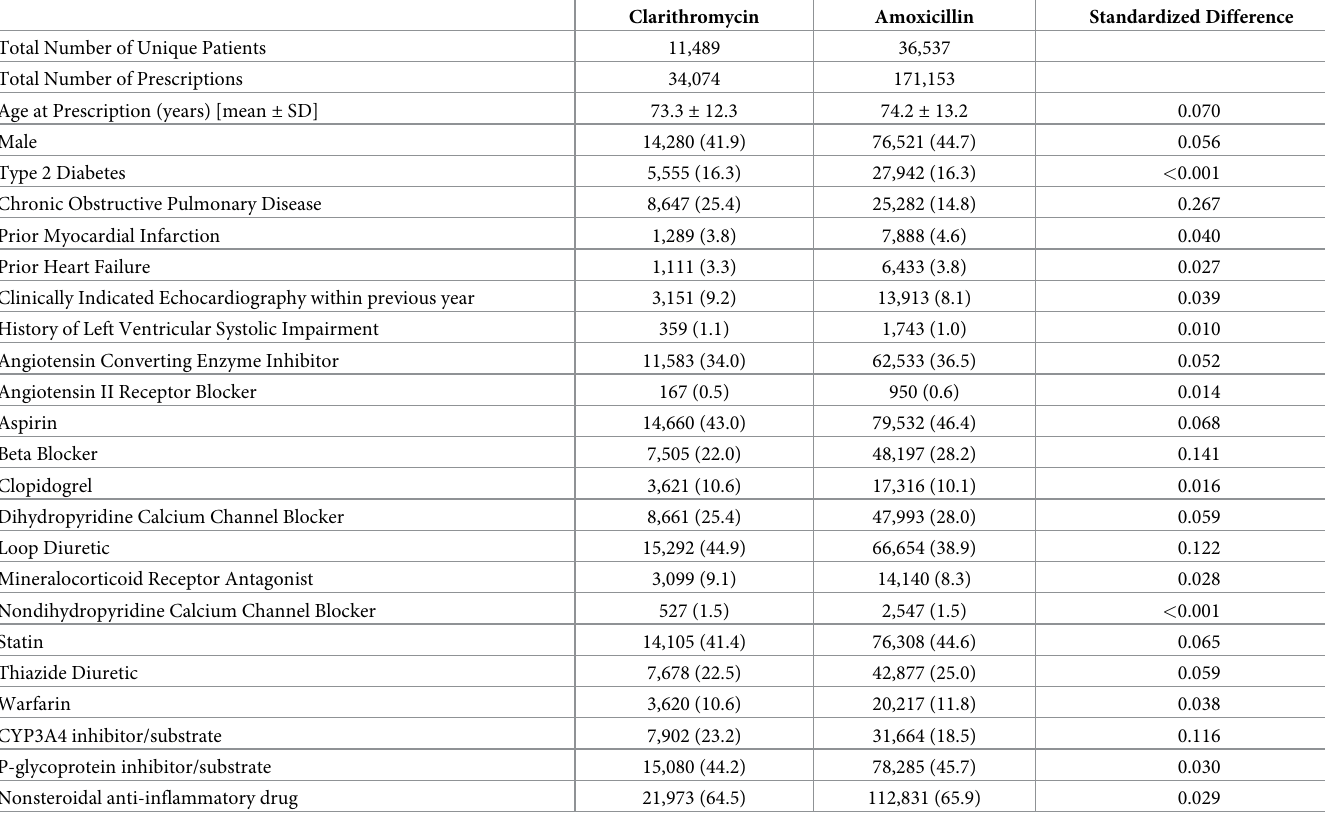
Table 1. Baseline characteristics of observational cohort study.